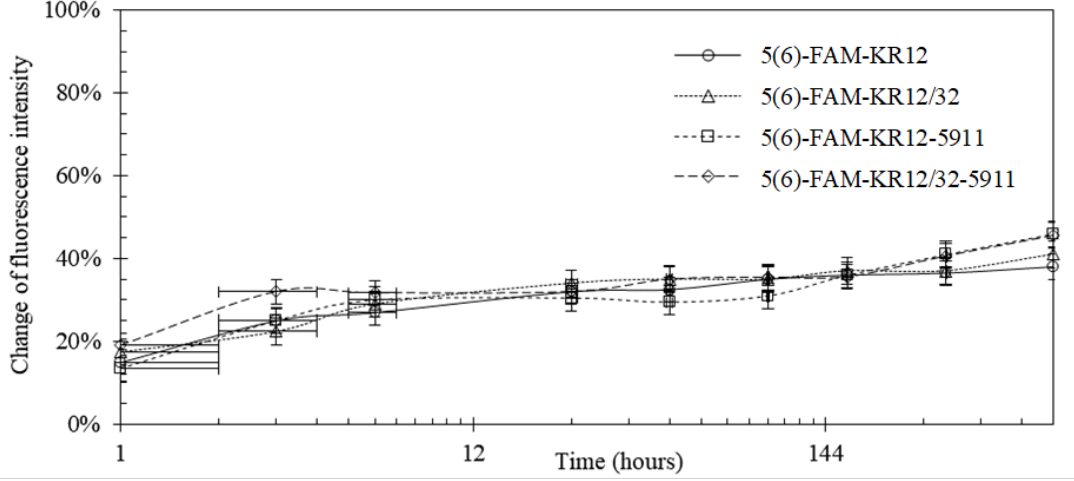
Figure 5. Release profile of 5(6)-FAM-labelled peptides that were released from the Ti6Al4V-coated surface based on fluorescence measurements; x-axis displayed in logarithmic scale (base = 12).